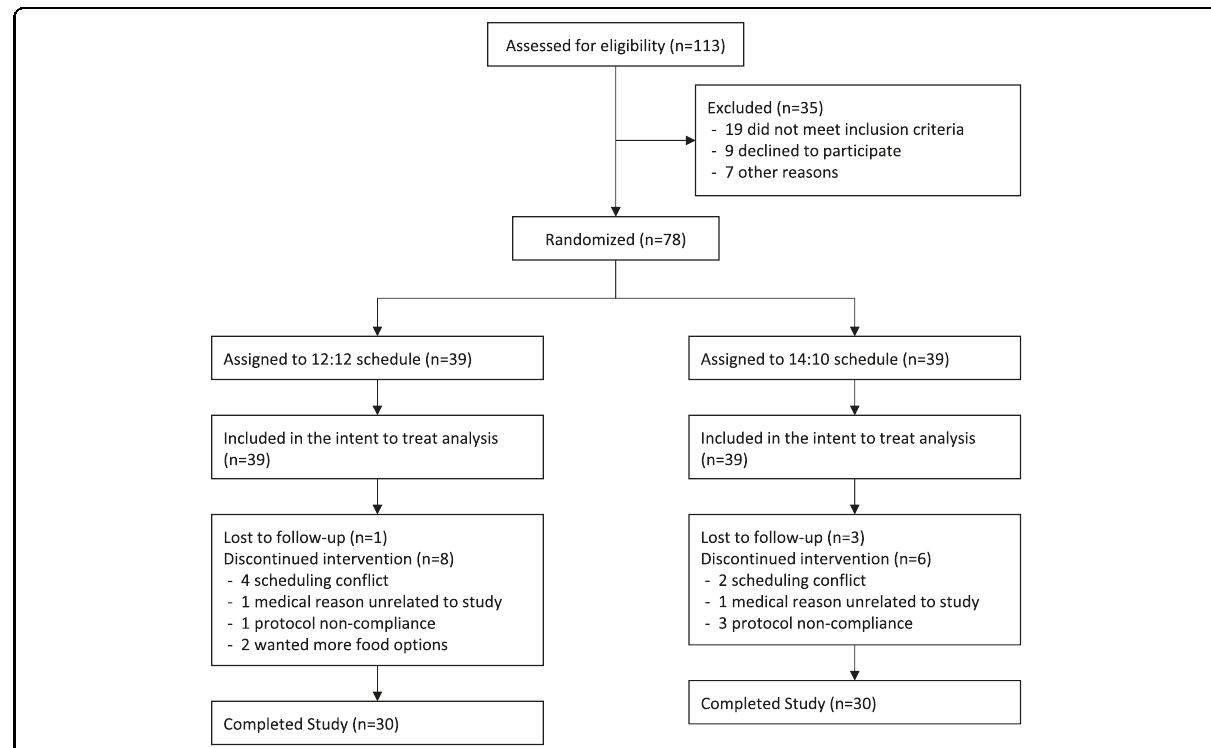
Fig. 1 Flow of study participants. Participant fl